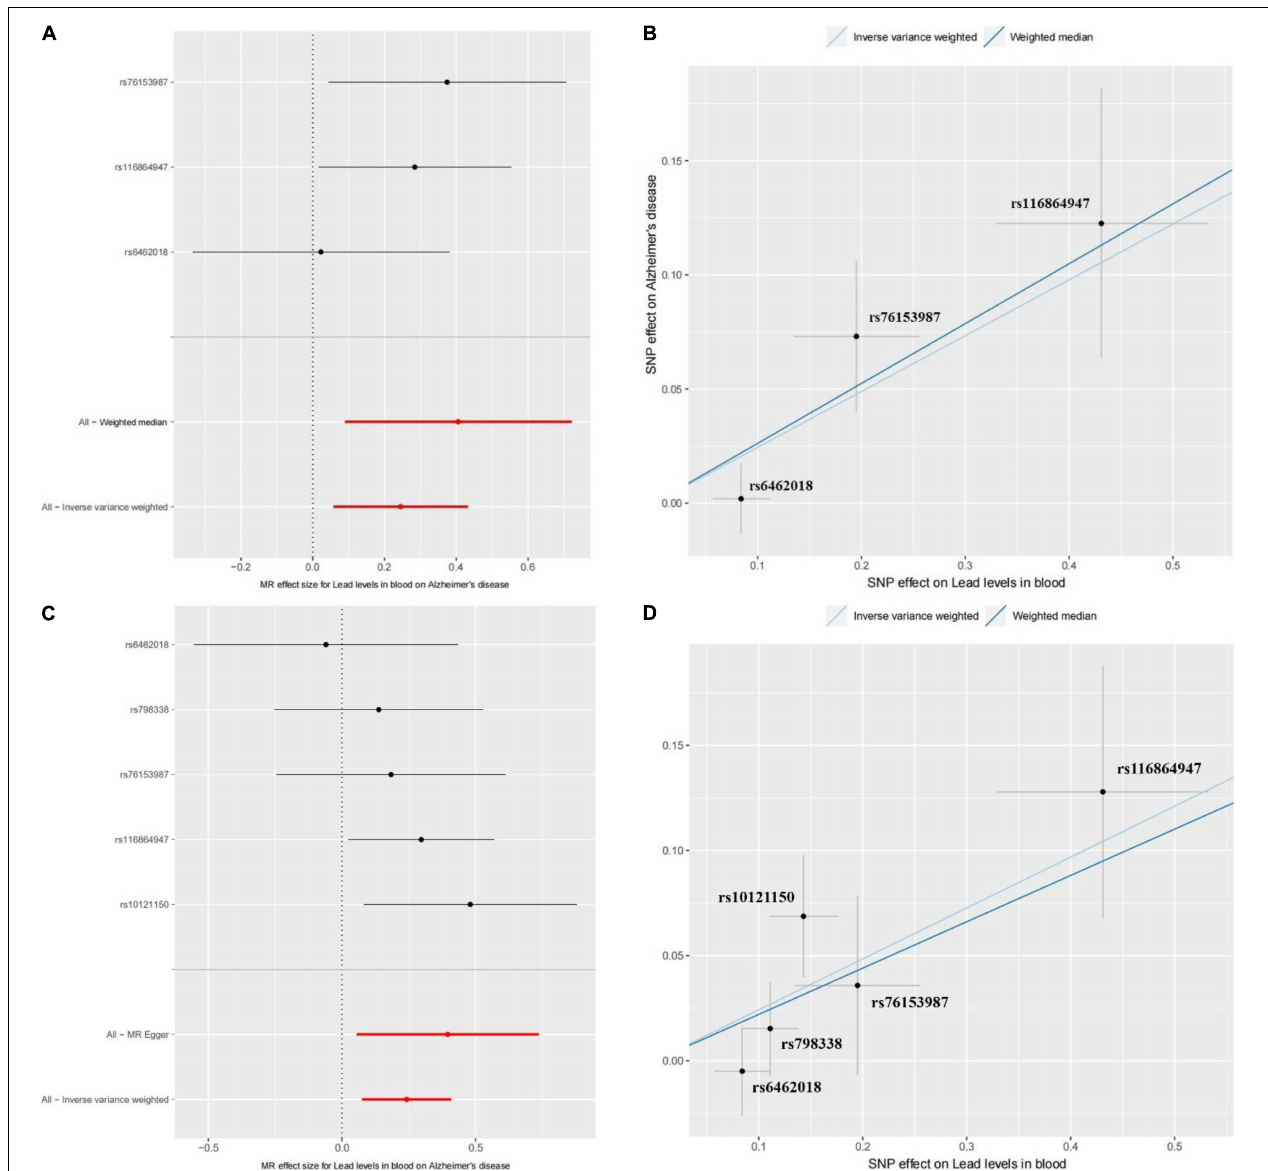
FIGURE 1 | The Mendelian randomization (MR) analysis for the causality of blood lead level and Alzheimer’s disease (AD) risk. (A) The forest plot represents the causal effect of blood lead level on AD using the Wald ratio. The Mendelian randomization using singly each SNP and all SNPs by the WME and IVW models are shown in it. (B) The method comparison plot shows the SNP effects on AD against SNP effects on blood lead levels in the WME and IVW models. Each method has a different line, and the slope of the line represents the causal association. Panels (C,D) show the forest plot of causal effect and the method comparison plot of WME and IVW models for the EFO_0000249 dataset,